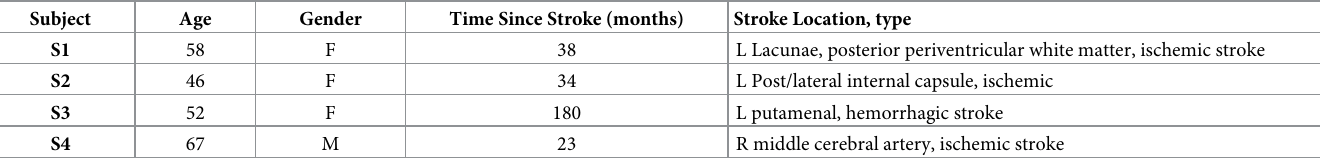
Table 1. Subject characteristics.